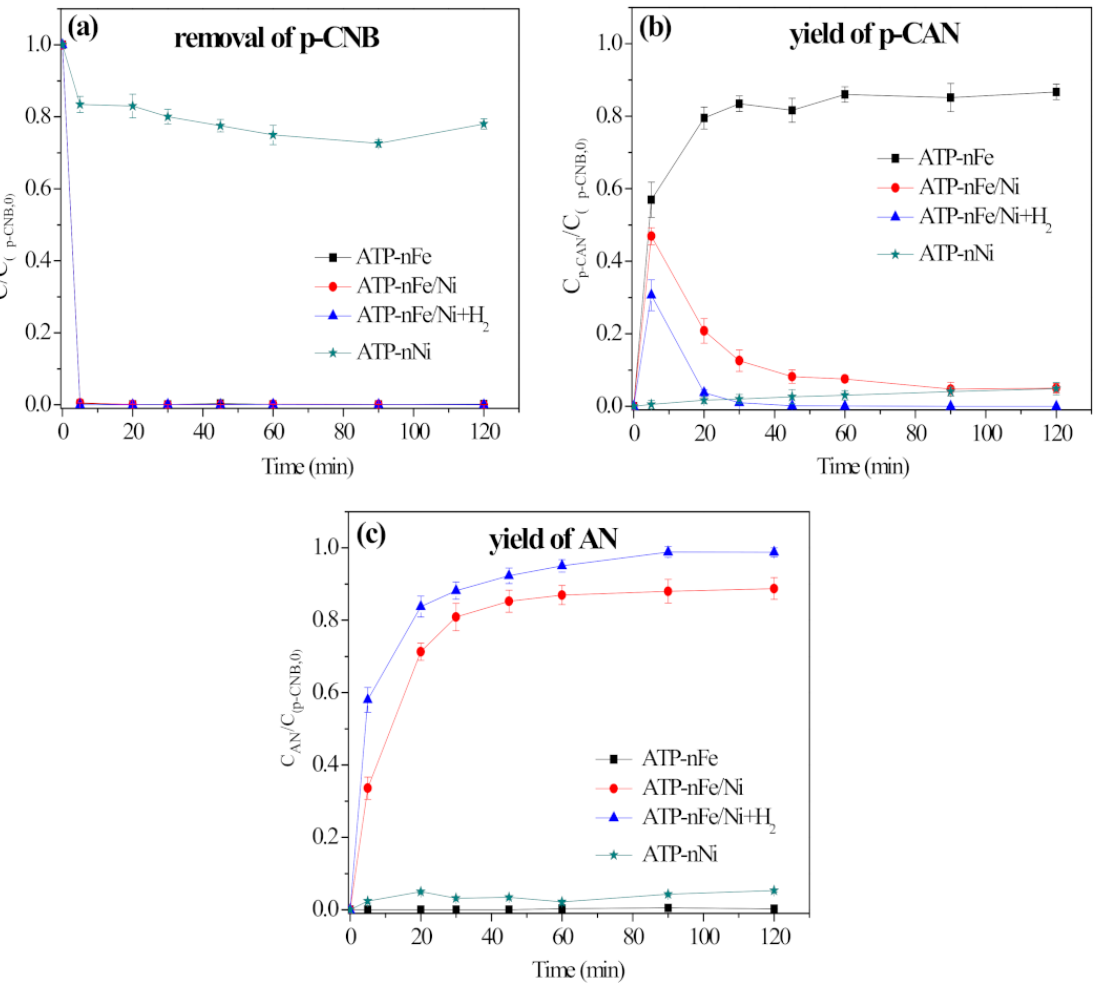
Figure 11. Removal of p-CNB by different materials ( a ), the yield of p-CAN ( b ) and the yield of AN ( c ) (reaction conditions: concentration of p-CNB = 10 mg/L, concentration of H 2 = 800 µ g/L, dosage of material = 0.5 g/L and initial pH = 5.6 ±